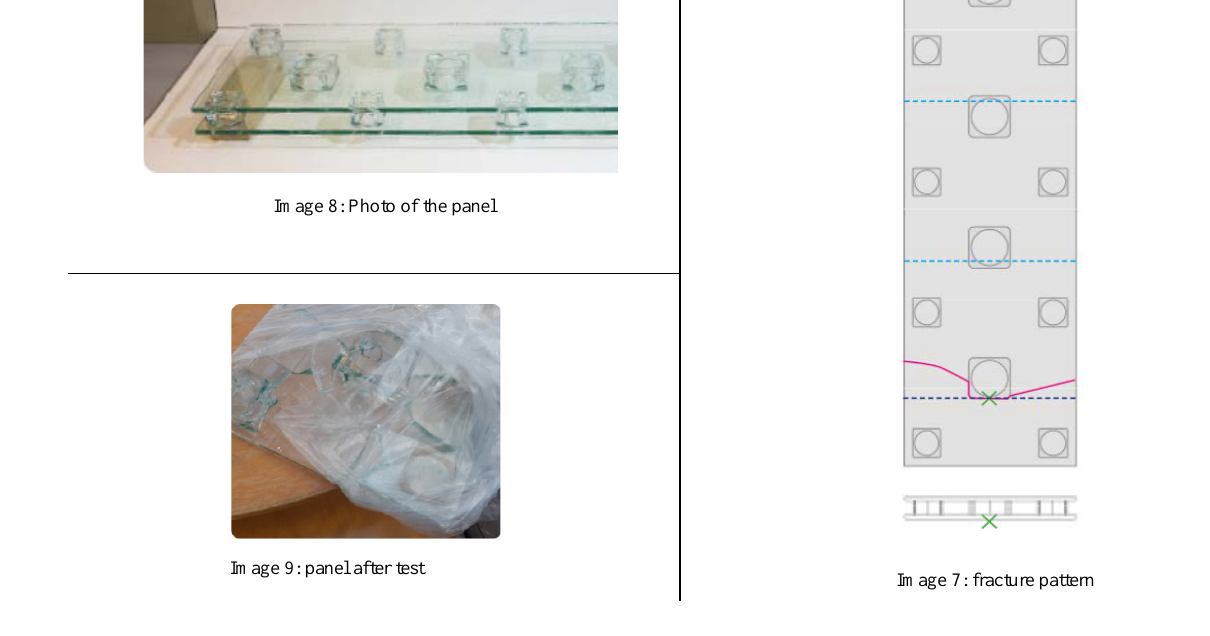
Comparison between panels 4 and 5: Panel 5